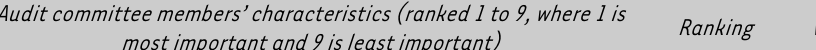
Number % Total Yes No Yes No